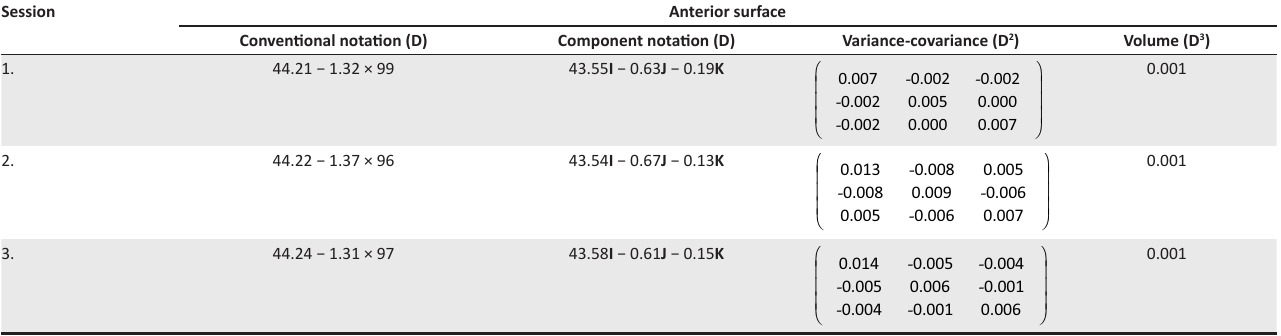
TABLE 1: Means are included in conventional and component notation with variance-covariance matrices, 95 % distribution ellipsoid volumes for the anterior surface corneal curvature measurements. Session Anterior surface Conventional notation (D)